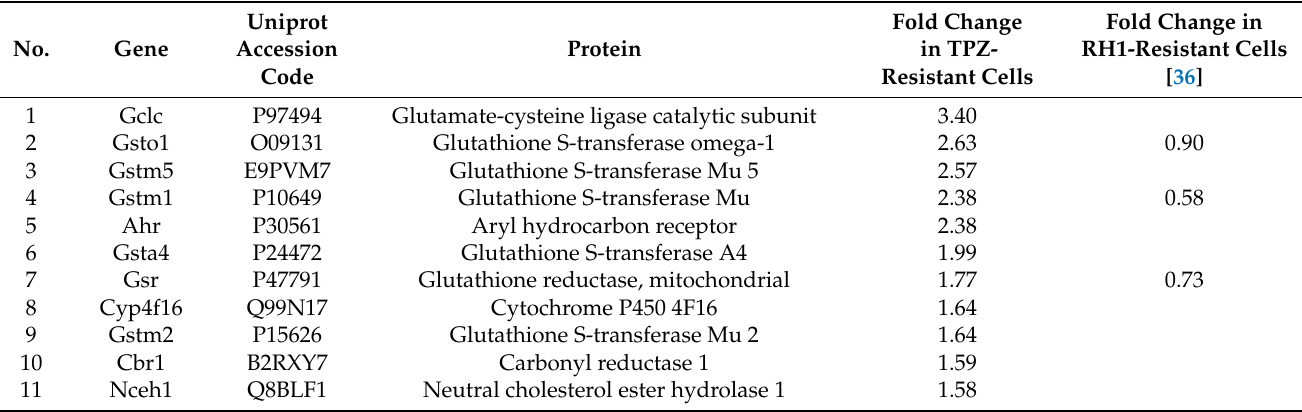
Table 3. Differently expressed enzymes of xenobiotics metabolism and catabolism, and glutathione metabolism in TPZ-resistant MH22a cells.